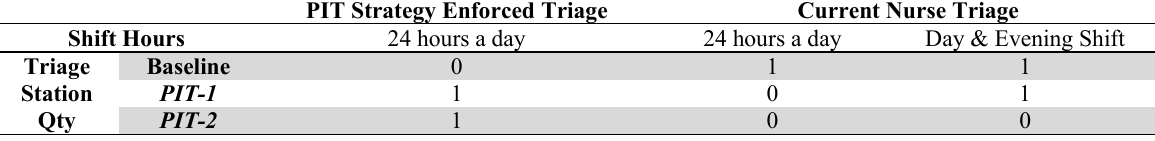
Two interventions using the PIT strategy compared to the baseline model PIT Strategy Enforced Triage